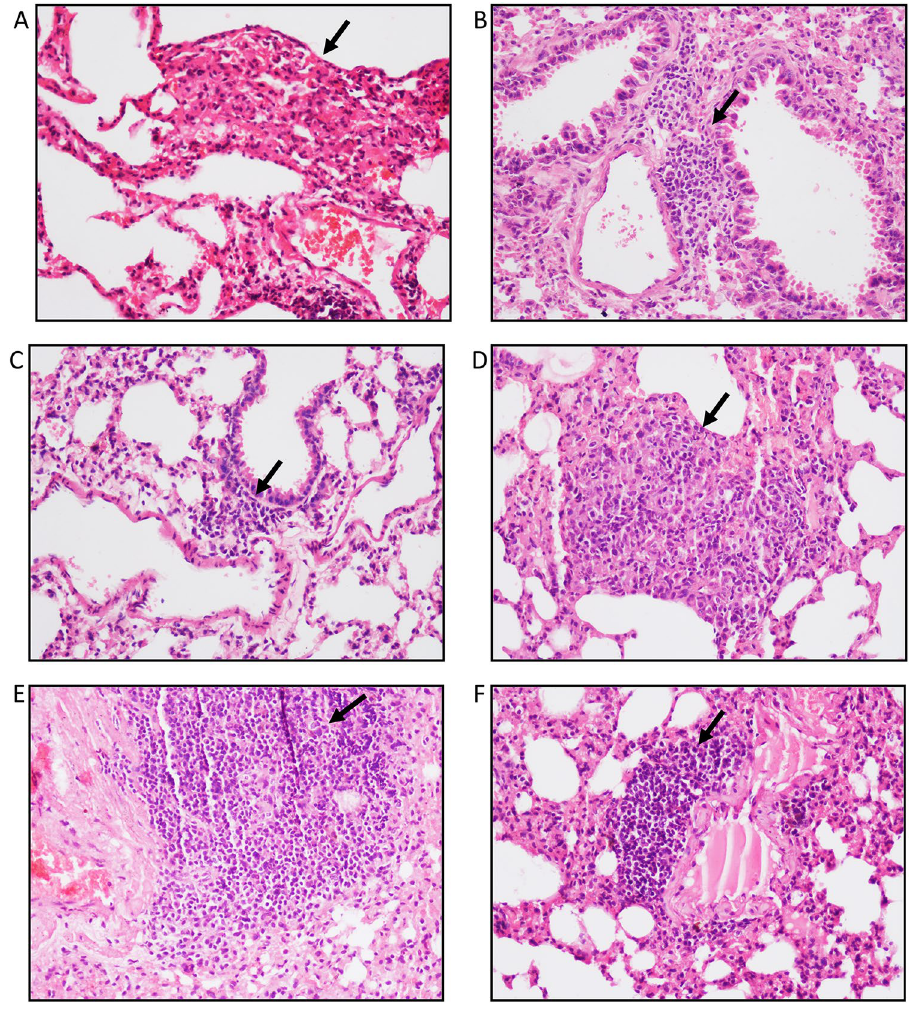
Figure 2. Histological examination of lung morphology to assess the presence of granulomas. After diabetes development, Hematoxylin & Eosin staining was performed on lung tissue of mice from Group-I, II and III at week 9 and 13 of streptozotocin treatment. Lung section of ( A ) Group-I mice ( B ) Group-II mice ( C ) Group-III mice after 9 weeks; Lung section of ( D ) Group-I mice ( E ) Group-II mice ( F ) Group-III mice after 13 weeks of streptozotocin treatment. Arrows indicate granulomas ( A , D ) and inflammation ( B , C , E , F ). Images were taken at 20× magnification. Group-I: latent tuberculosis only, Group-II: latent tuberculosis with diabetes and Group-III: latent tuberculosis with